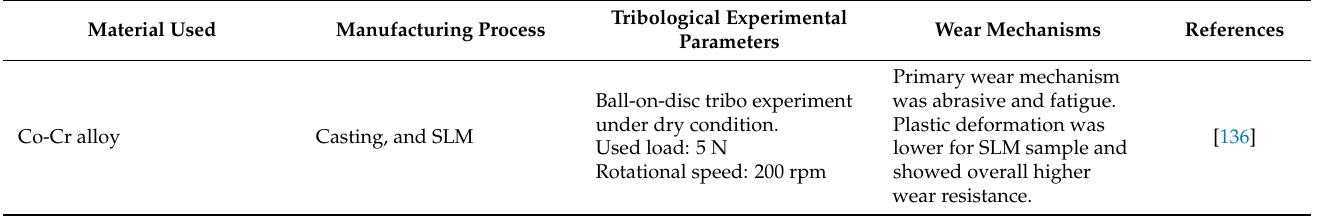
Table 8. Tribological studies on commonly used metallic implant materials for dental prosthesis. Material